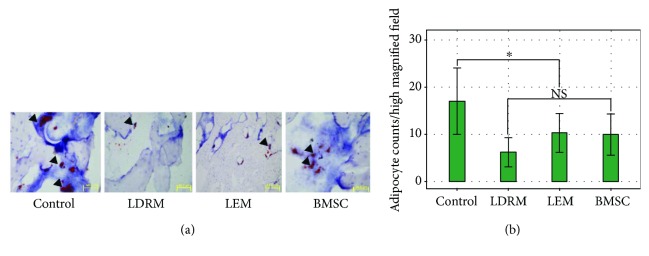
In vivo Oil Red O staining of femoral heads from rats (a) and the measured data (b). The control group contained significantly more adipocytes (black triangle) per high magnified filed (17.05 ± 7.03, P < 0.05) than the other groups (6.21 ± 3.06, 10.32 ± 4.12, and 9.97 ± 4.35 in LDRM, LEM, and BMSC, resp., P > 0.05), and the cell size was also larger in the control group than that in others (scale bar = 50 μm. NS, P > 0.05; ∗
P < 0.05).